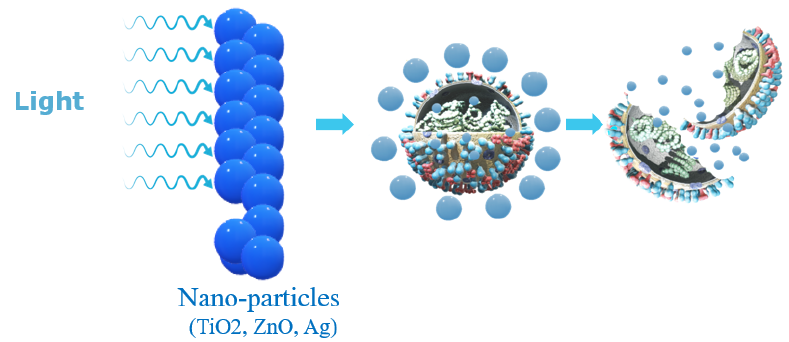
Figure 1. Action of Nanoxen on pathogens (Taken from Nanoxen-Nano Coatings